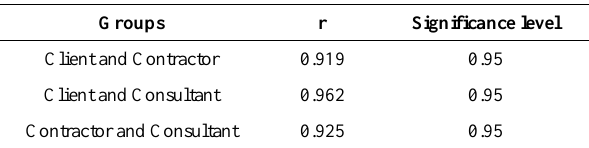
Table 7. Spearman rank correlation coefficient for